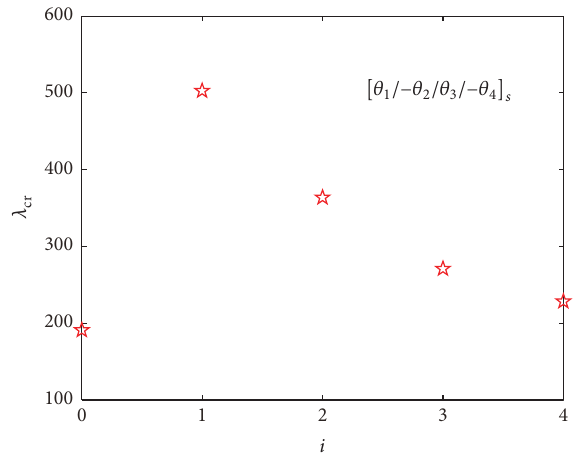
Figure 5: Flutter boundary versus position of layer embedded with SMA wires ( 𝑖 = 0 , [60/ − 60/60/ − 60] 𝑖 = 2 , [60/ 0 SMA /60/ − 60] [60/ − 60/60/ 0 SMA ]